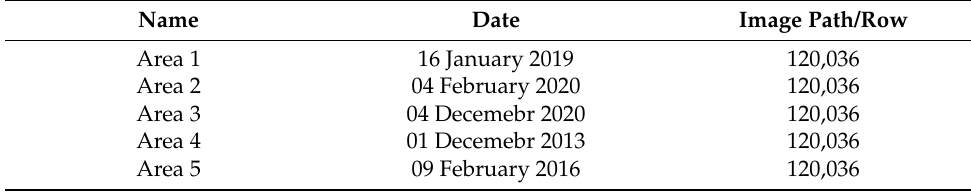
Table 1. Introduction to the study areas.